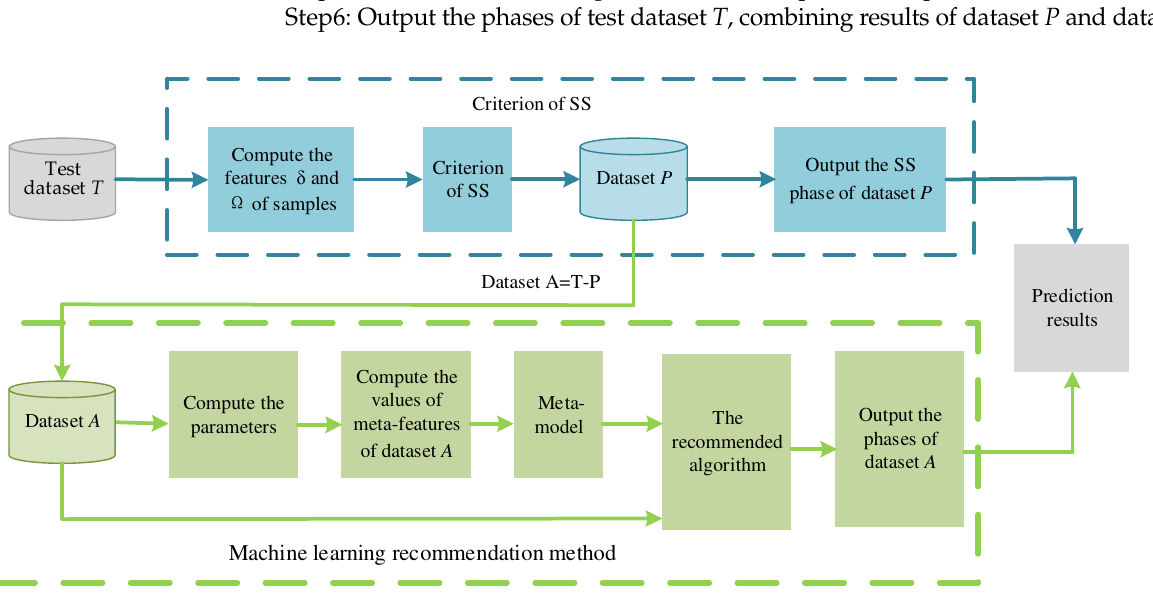
Figure 4. Schematic diagram of phase prediction frame of HEAs.